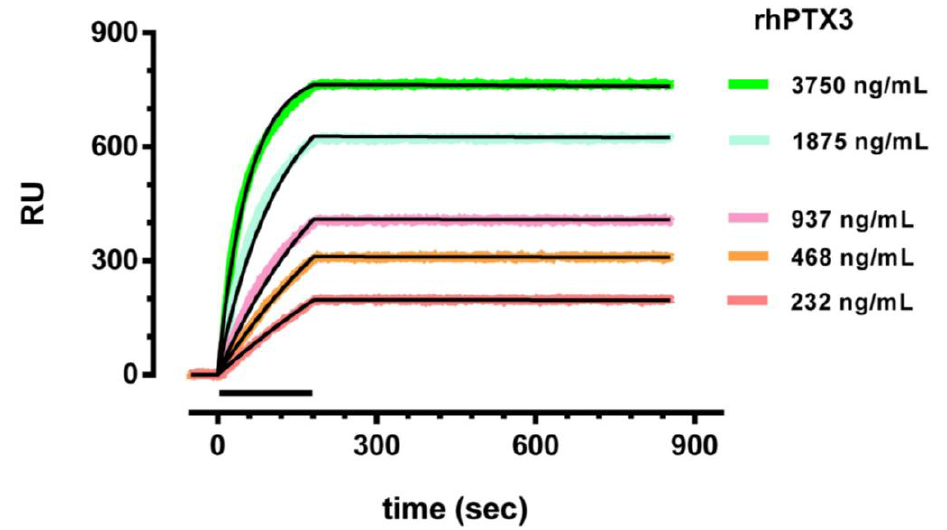
Figure 2. Binding of rhPTX3 to MNB4, in buffer. Different concentrations of rhPTX3 were injected for 3 min (bar), at a flow rate of 30 µL/min, over MNB4 immobilized on the sensor chip surface. The running buffer (also used to dilute rhPTX3) was 10 mM phosphate buffer containing 150 mM NaCl, added with 0.005% Tween 20 (PBST, pH 7.4). Sensorgrams were obtained after subtraction of the nonspecific response measured in parallel in surface immobilizing anti-CRP antibody (used as reference) and after correction for the signal when vehicle was injected alone. The curves were analyzed by the Langmuir equation, modelling a simple bimolecular interaction, and the fittings are shown in